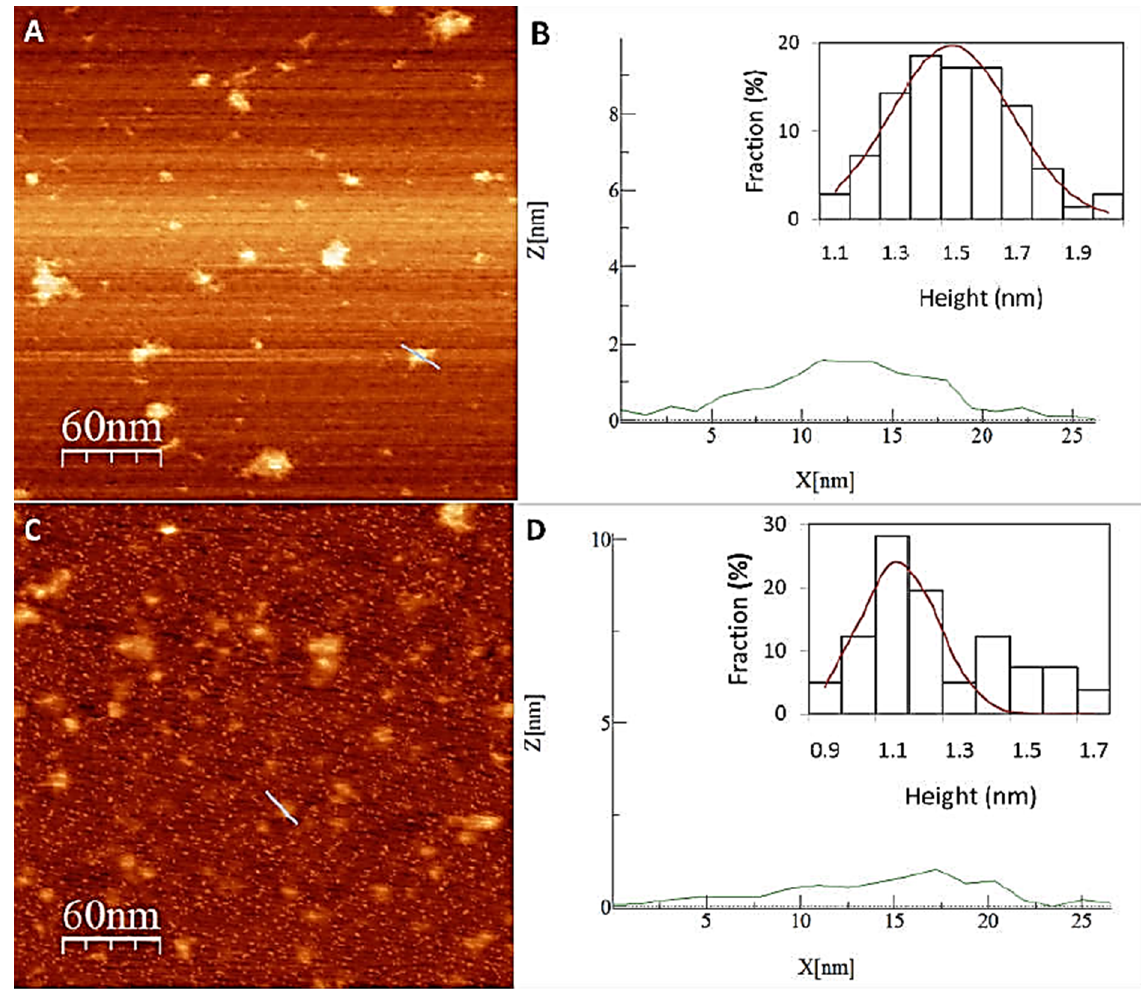
Figure 5. Atomic force microscopy (AFM) images of CS180 ( A ), CSU180 ( C ) images ( B , D ). The insets are the size distribution of CNDs and line profile at selected line in AFM.